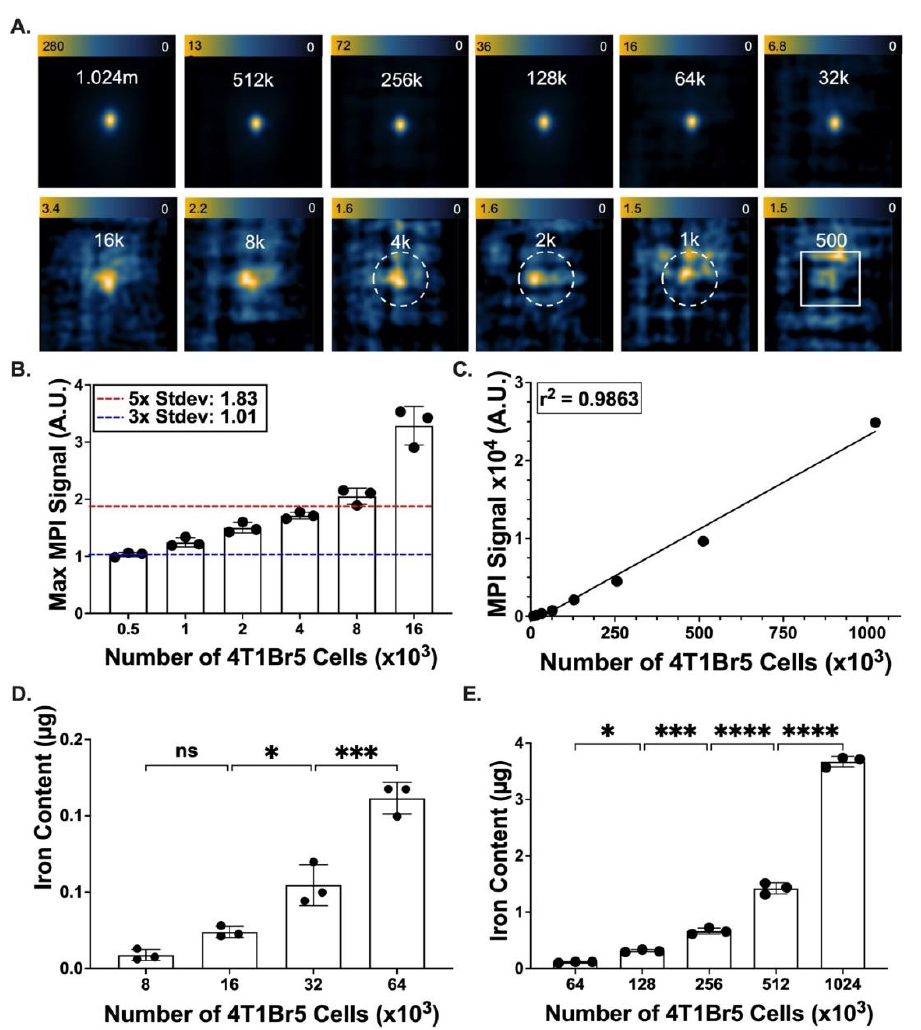
Figure 3. Cell detection limits for Synomag-D-labelled 4T1Br5-tdT-Akaluc cells. ( A ) 2D MPI of Synomag-D-labelled 4T1Br cells of different cell numbers (range 500–1.024 × 10 6 cells), where “m” denotes million and “k” denotes thousand. Dotted circles indicate cell numbers that produce